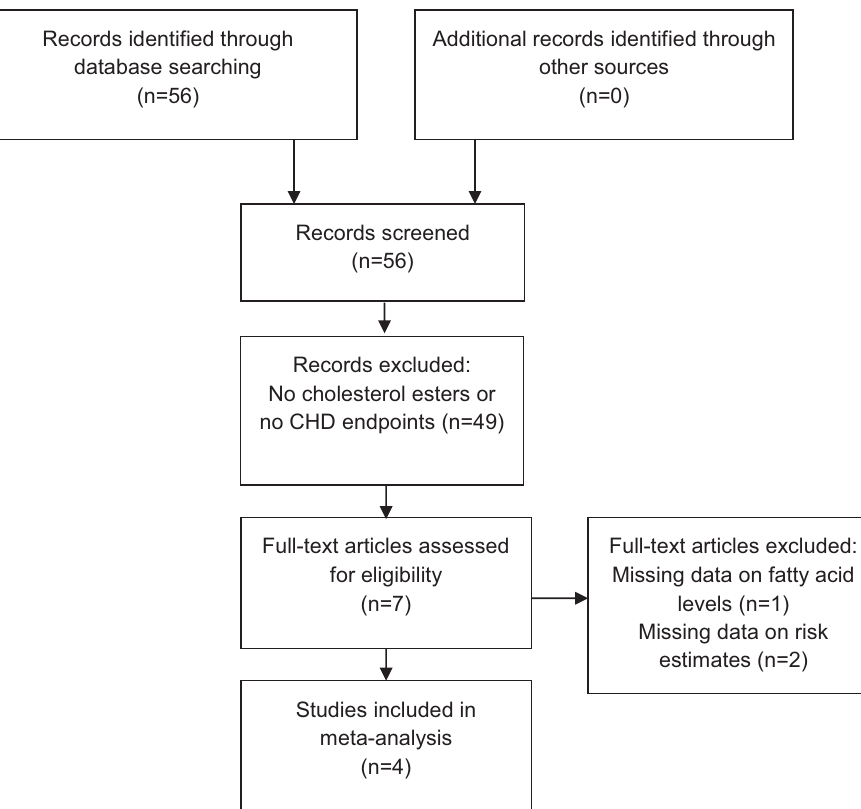
Figure 1. PRISMA 2009 Flow diagram meta-analysis.